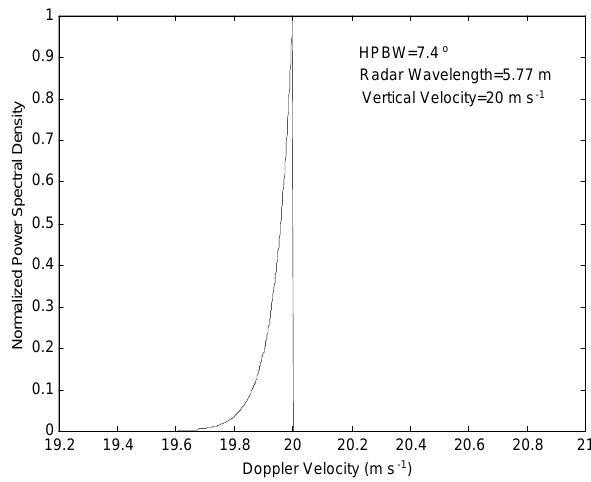
Fig. 2. Example of normalized beam broadening spectrum caused solely by vertical wind, in which a radar wavelength of 5.77m (cor- responding to 52MHz), radar beam with half-power beam width of 7.4 ◦ and 20ms − 1 vertical wind velocity are employed in the calcu-